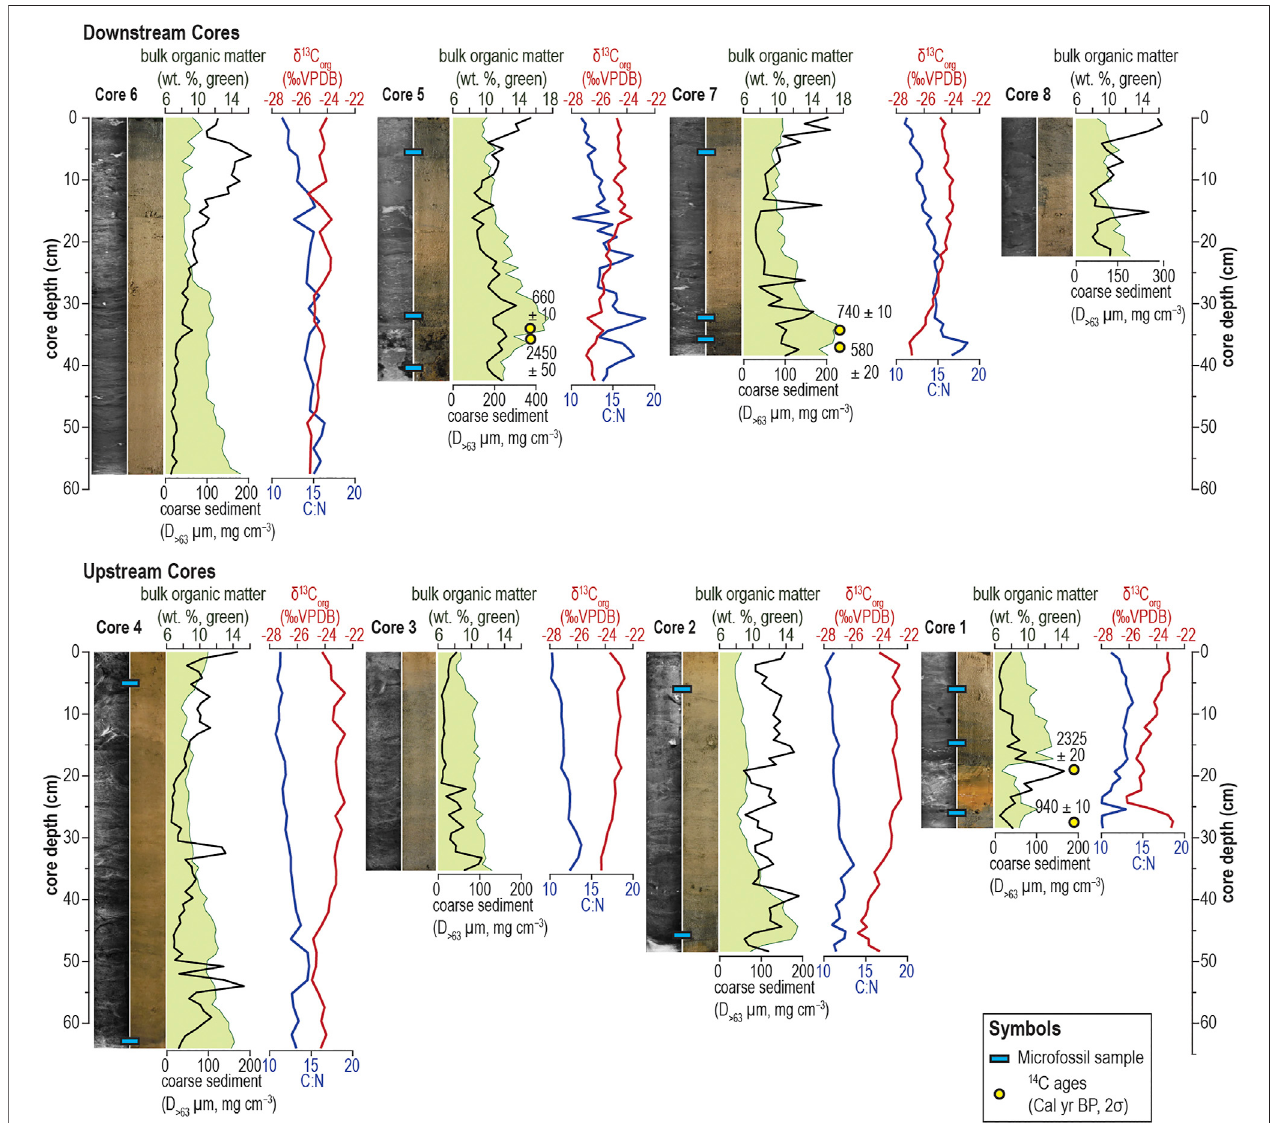
FIGURE 3 | Detailed photographs and x-radiographs of sediment cores are shown with downcore coarse-grained particle deposition (Sieve- fi rst LOI, D > 63 μ m), bulk organic matter (Classic LOI, weight %), stable carbon isotopic values ( δ 13 C org ), and C:N ratios. Radiocarbon and microfossil sample positions are marked on relevant